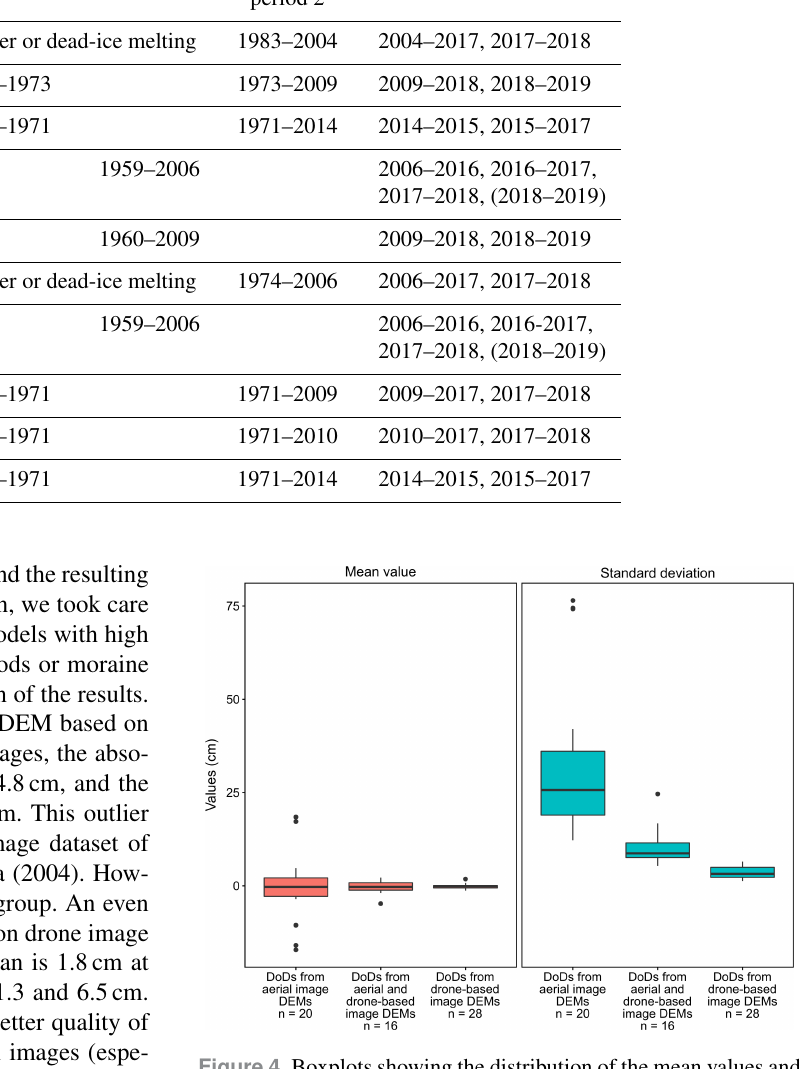
Figure 4. Boxplots showing the distribution of the mean values and standard deviations for different types of DoDs: DoDs from aerial image DEMs, DoDs from aerial and drone-based image DEMs, and DoDs from drone-based image